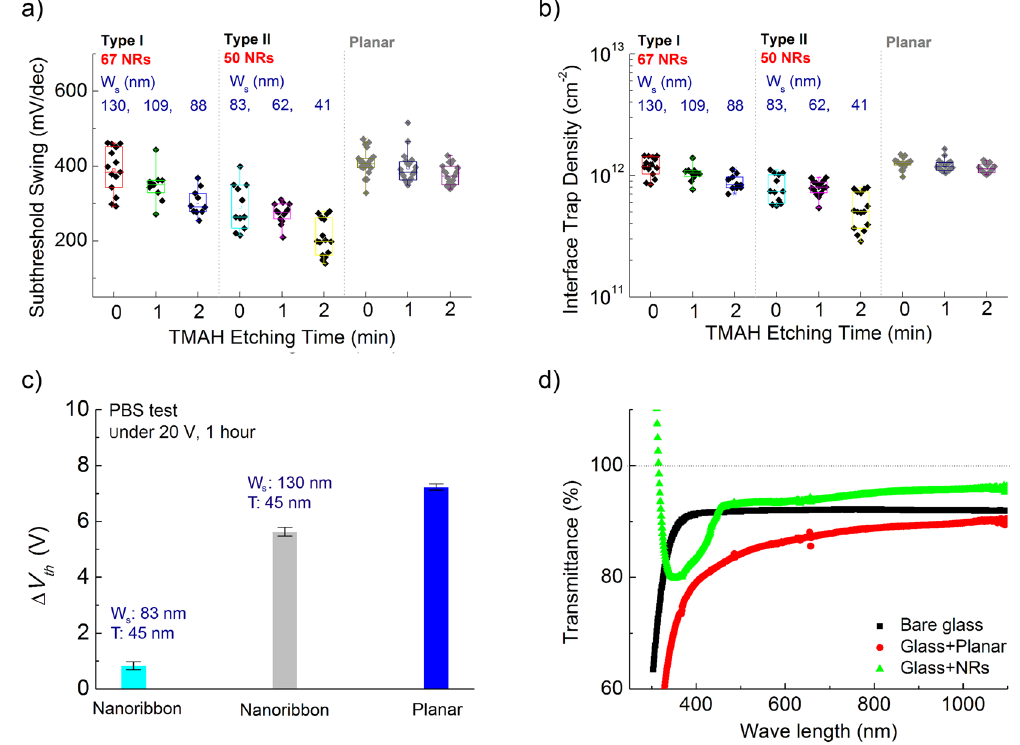
Figure 8. ( a ) SS and ( b ) interface trap density distribution of NR and planar TFTs. ( c ) The V th shift determined by the PBS stress tests, averaged over at least 10 NRs devices and planar TFTs. The V th shift is equal to the change between the initial value and the value obtained after a constant 20 V has been applied to the back gate electrode for 1 h. ( d ) Transmittance in the visible wavelength regime of bare glass, a-IGZO film, and NR structure on a glass